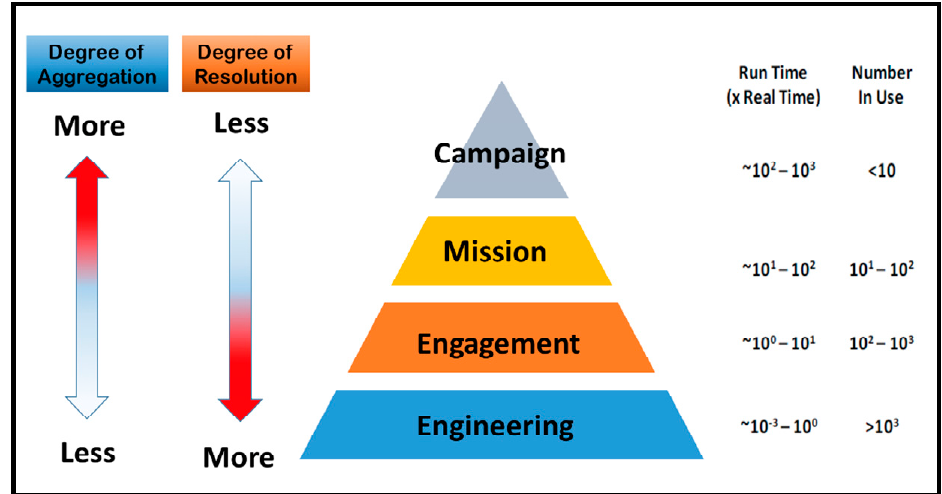
Figure 3. Different degrees of resolution and its relationship with aggregation (modified and adapted from Mullen et al. [9].